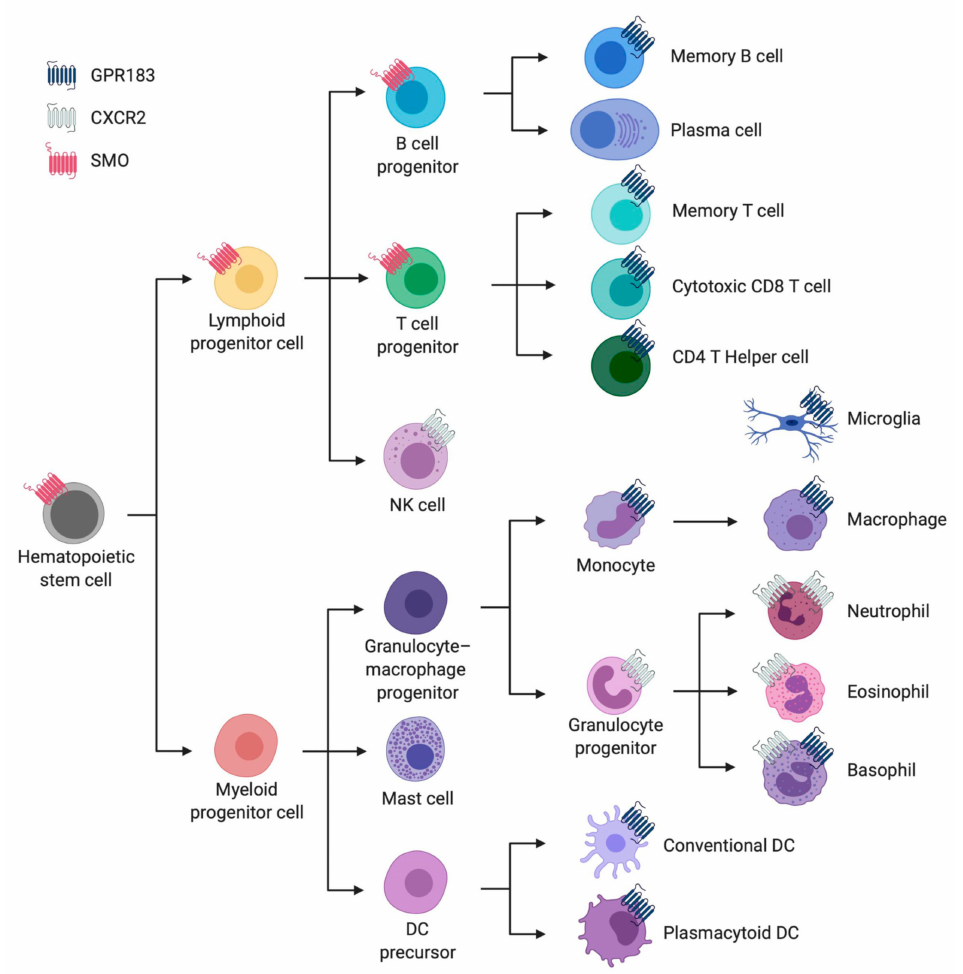
Figure 2. Overview of the main immune cell types from the hematopoietic lineage with an ab- straction of their cellular expression of the three GPCRs discussed in this article. These GPCRs are represented by three distinct colours: purple for GPR183, light grey for CXCR2 and red for SMO . This overview was created in BioRender (BioRender.com) and is based on a consensus from four independent transcriptomic data sets from human immune cells [37–39], as summarized in Supplemental Figure